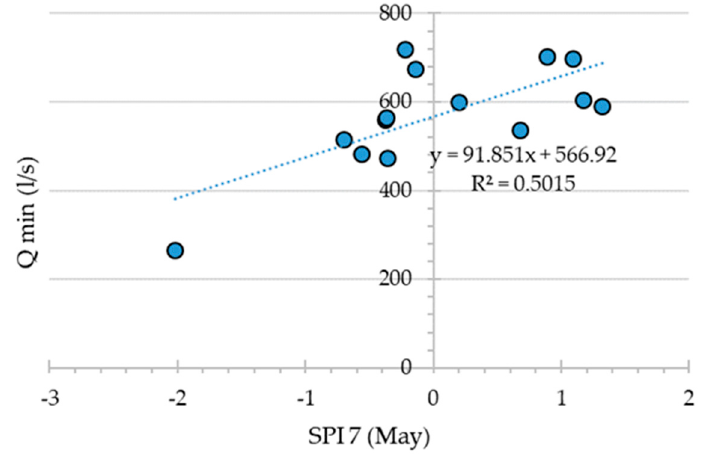
Figure 10. Relationship between Q min of the historical discharge series and SPI7 (May). Figure 9. Relationship between Q min of the historical discharge series and SPI7 (May).